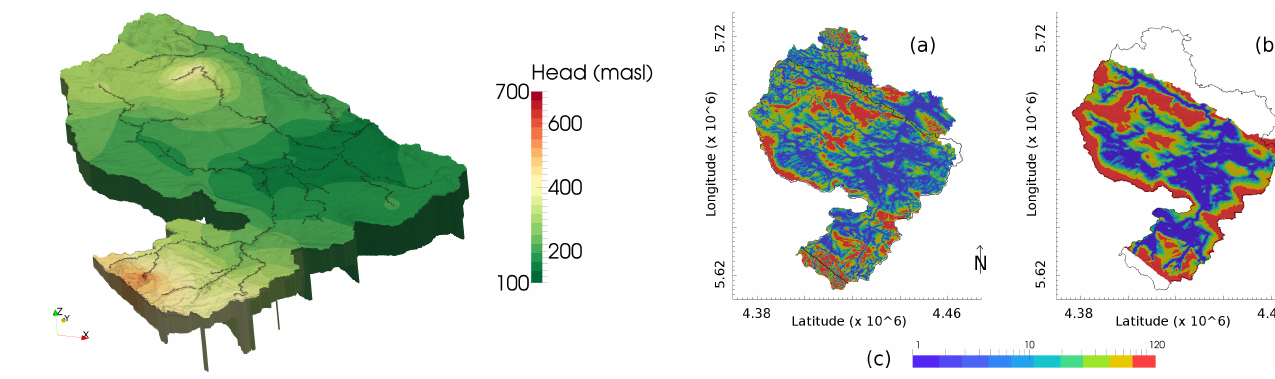
Figure 11. Comparison of observed and simulated depth from sur- face to groundwater level; observation data courtesy of TLUG, based on regionalized observations of groundwater head measure- ments: (a) observation, resolution 10m 10m, (b) simulation, res- × olution 250m 250m, and (c) legend depth to groundwater surface × (m).